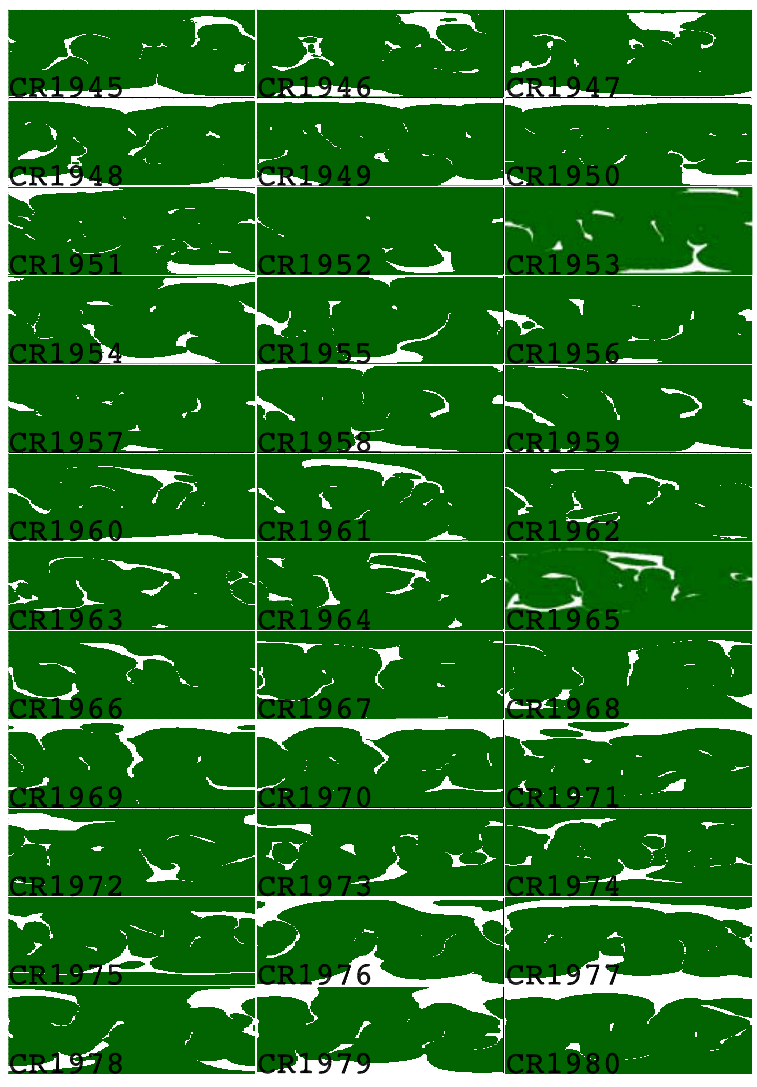
Fig. 3. Computed coronal hole boundaries for CR1945 to CR1980. Green indicates regions of closed magnetic fields and white indicates regions of open magnetic fields (i.e. coronal